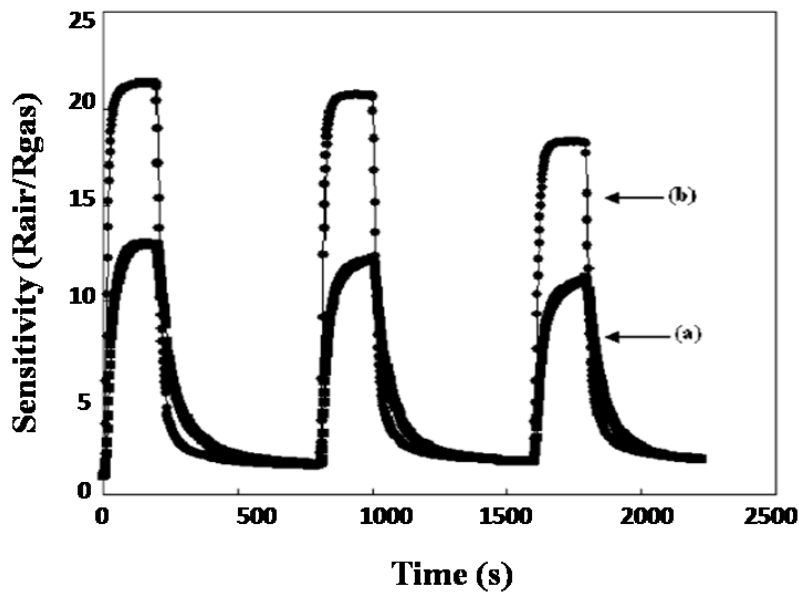
Figure 4. Repetitive response of the ( a ) as-synthesized and ( b ) thermally treated SnO 2 to ethanol (25 ppm) at 220 °C. (Reprinted with permission from [70]. Copyright 2007, American Chemical Society, Washington, DC, USA).